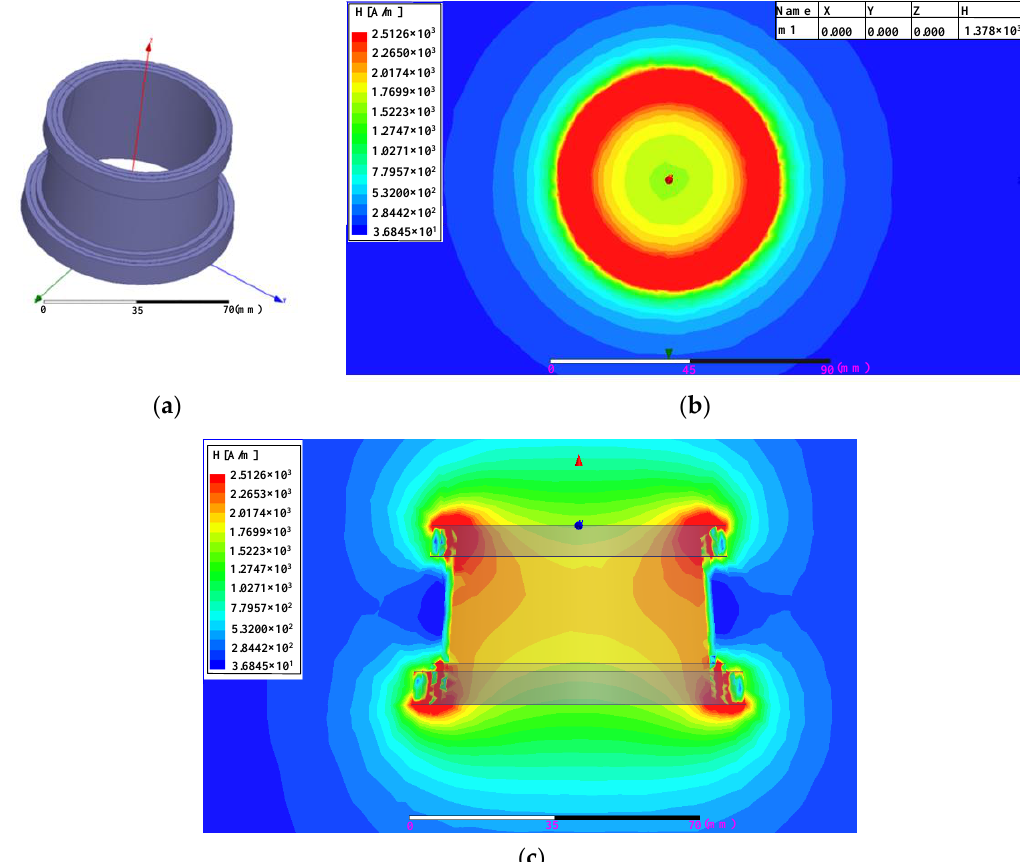
Figure 5. The structure of the coil and simulated electromagnetic field: ( a ) structural diagram; ( b ) X–Y section of the electromagnetic field; and ( c ) X–Z section of the magnetic field.